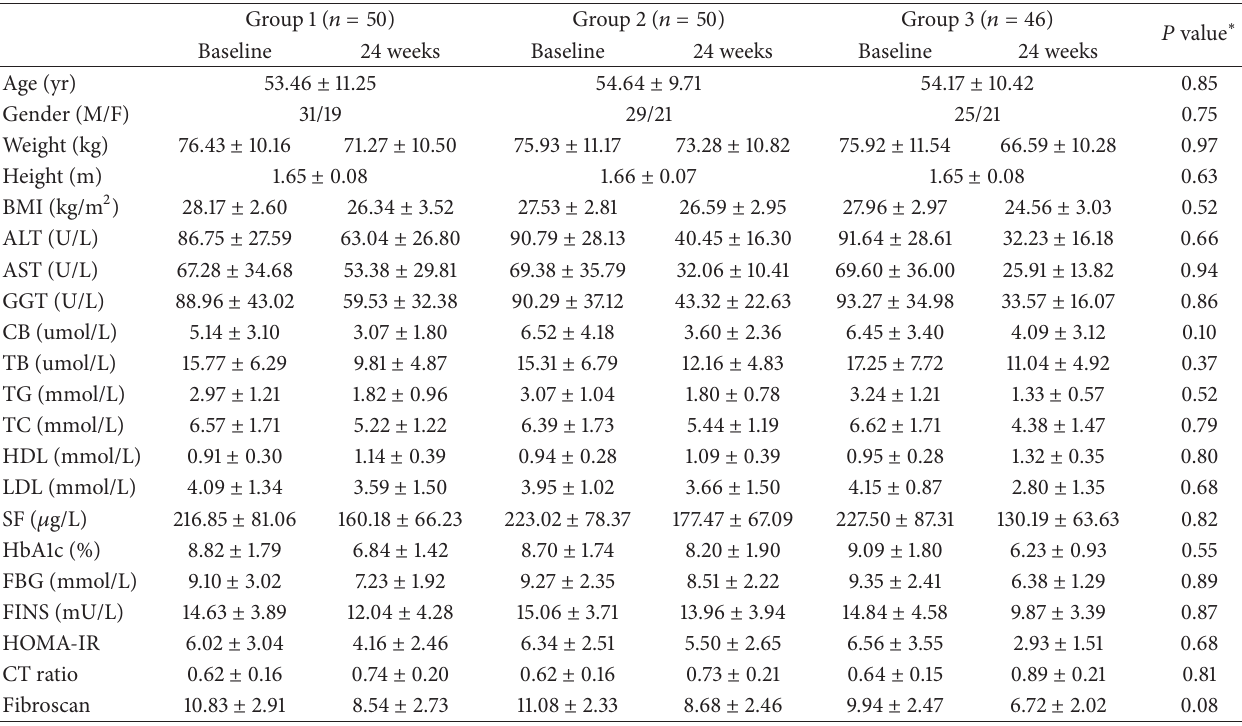
Table 1: Parameters of patients with T2DM and NAFLD at baseline.